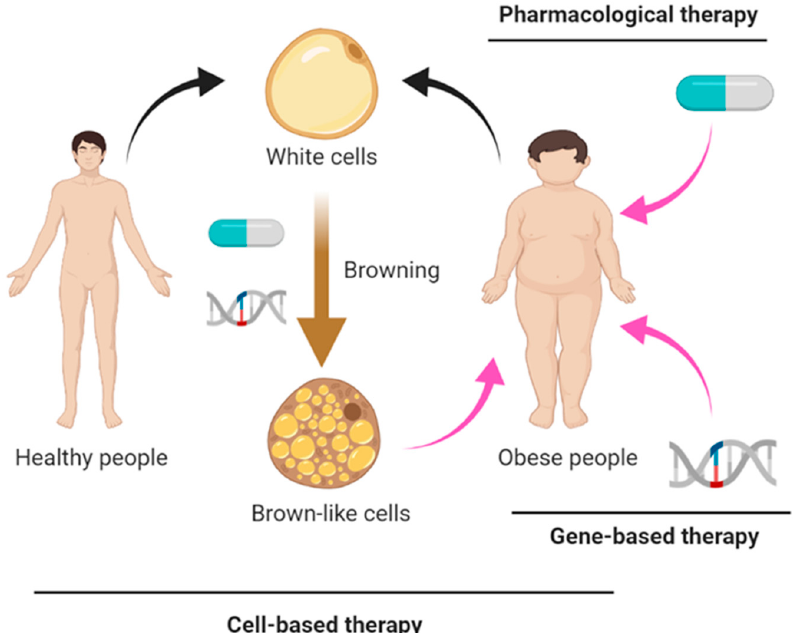
Figure 1. Cell-based, gene-based and pharmacological therapies to increase thermogenic adipocytes in obese subjects. In pharmacological therapies, several compounds, proteins, lipids or metabolites have been applied for treatment of obesity through the regulation of thermogenic adipocytes activity and energy expenditure. In gene therapy, the delivery of DNA (transgene), mRNA, microRNA, or Cas9/gRNA system can be used to modulate the expression of genes involved in the thermogenic pathway. Cell-based therapies include autologous and allergenic cell therapies depending on the source of the transplanted cells. Precursor cells isolated from obese subjects (autologous) or healthy donors (allergenic) can be engineered and differentiated to thermogenic adipocytes followed by transplantation of the fat back to the obese subjects.